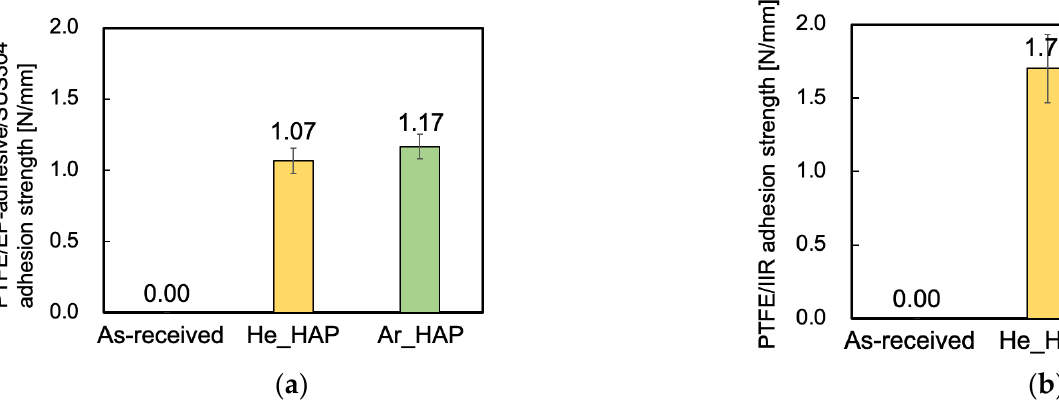
Figure 2. Adhesion properties of the PTFE samples HAP-treated using He or Ar gas. (a) PTFE/EP-adhesive/SUS304 adhesion strength and (b) PTFE/IIR adhesion strength.